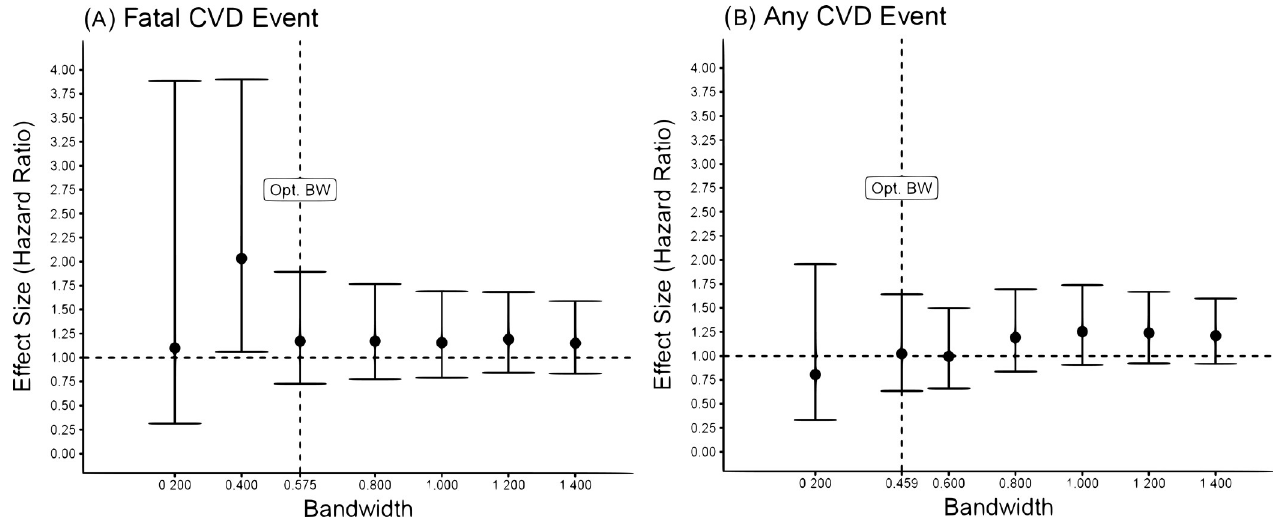
Fig 3. Graphical representation of the effect at the threshold for different bandwidths. Graphical representation of sensitivity analysis results on the effect of the intervention at the threshold (and respective 95% CIs) by changing the bandwidth around the cutoff for (Panel A) fatal CVD events results and (Panel B) any CVD event. The dotted line indicates the result with the optimal bandwidth from the main analysis. Other bandwidths indicate larger or narrower bandwidths: A larger bandwidth indicates that we are considering individuals farther away from the cutoff but also a larger number of observations (i.e., up to 1.4 units on the constructed BPS around the cutoff). A narrower bandwidth indicates that we are considering individual closer to the cutoff and therefore less observations (i.e., up to 0.2 units on the constructed BPS around the cutoff). BPS, blood pressure score; CI, confidence interval; CVD, cardiovascular disease.